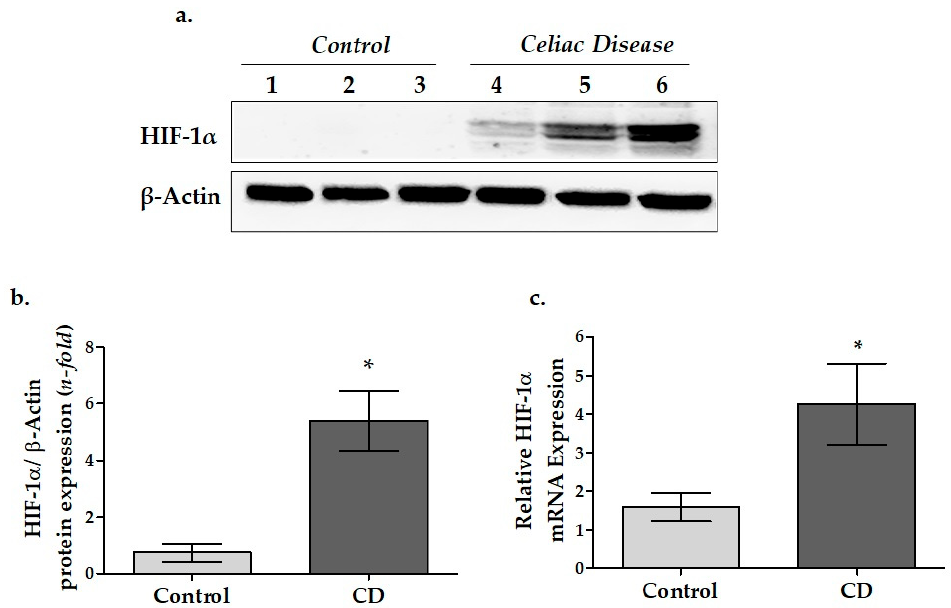
Figure 3. The relative protein and mRNA expression levels of HIF-1 α in the duodenal tissue. ( a ) Protein expression of HIF-1 α were determined by WB analysis. ( b ) Relative values of HIF-1 α were quantified by densitometric analysis. The β -actin signal was used to normalize the data. Data were expressed as the mean ± SEM ( n = 3). ( c ) The relative mRNA expressions were calculated with the 2 − ∆∆ CT method and normalized to GAPDH ( n = 7/7). Data were expressed as the mean ± SEM. * p < 0.05 versus the control group (CD: celiac disease group).